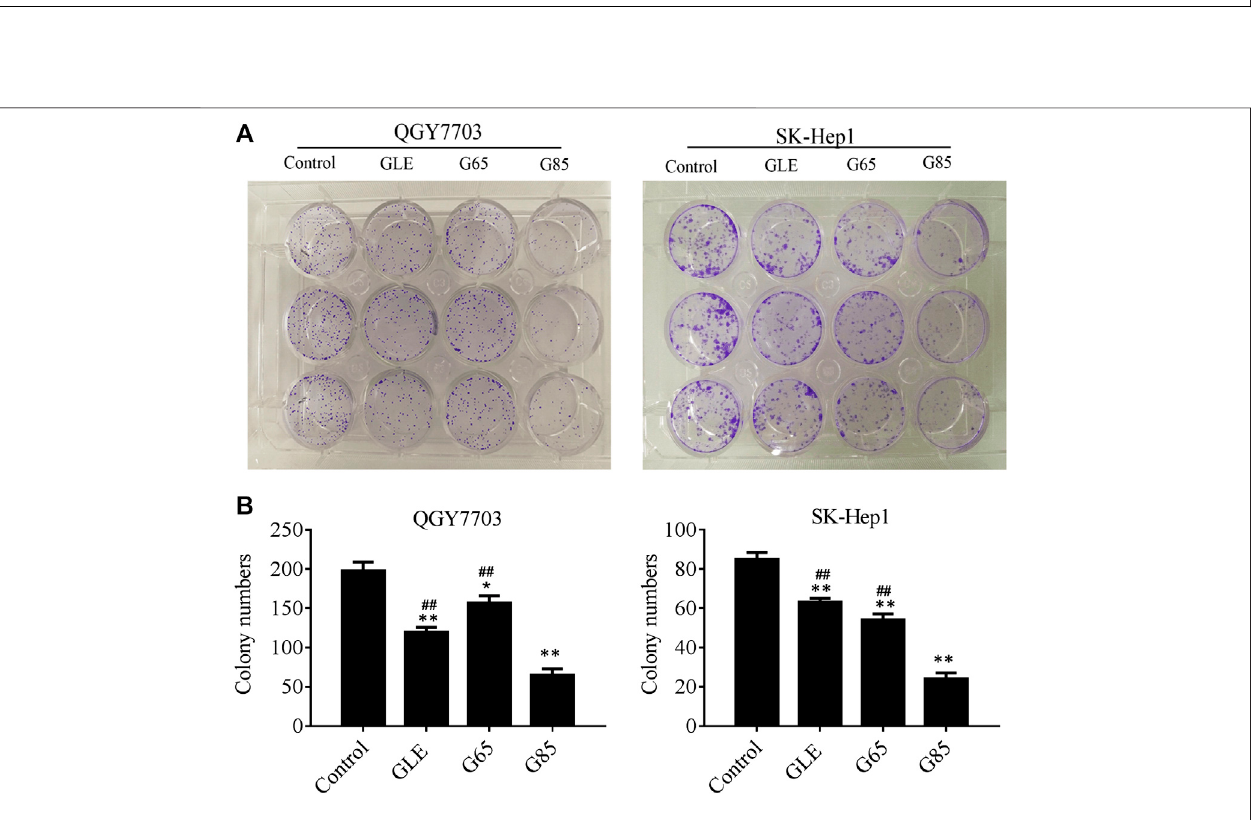
Frontiers in Pharmacology |